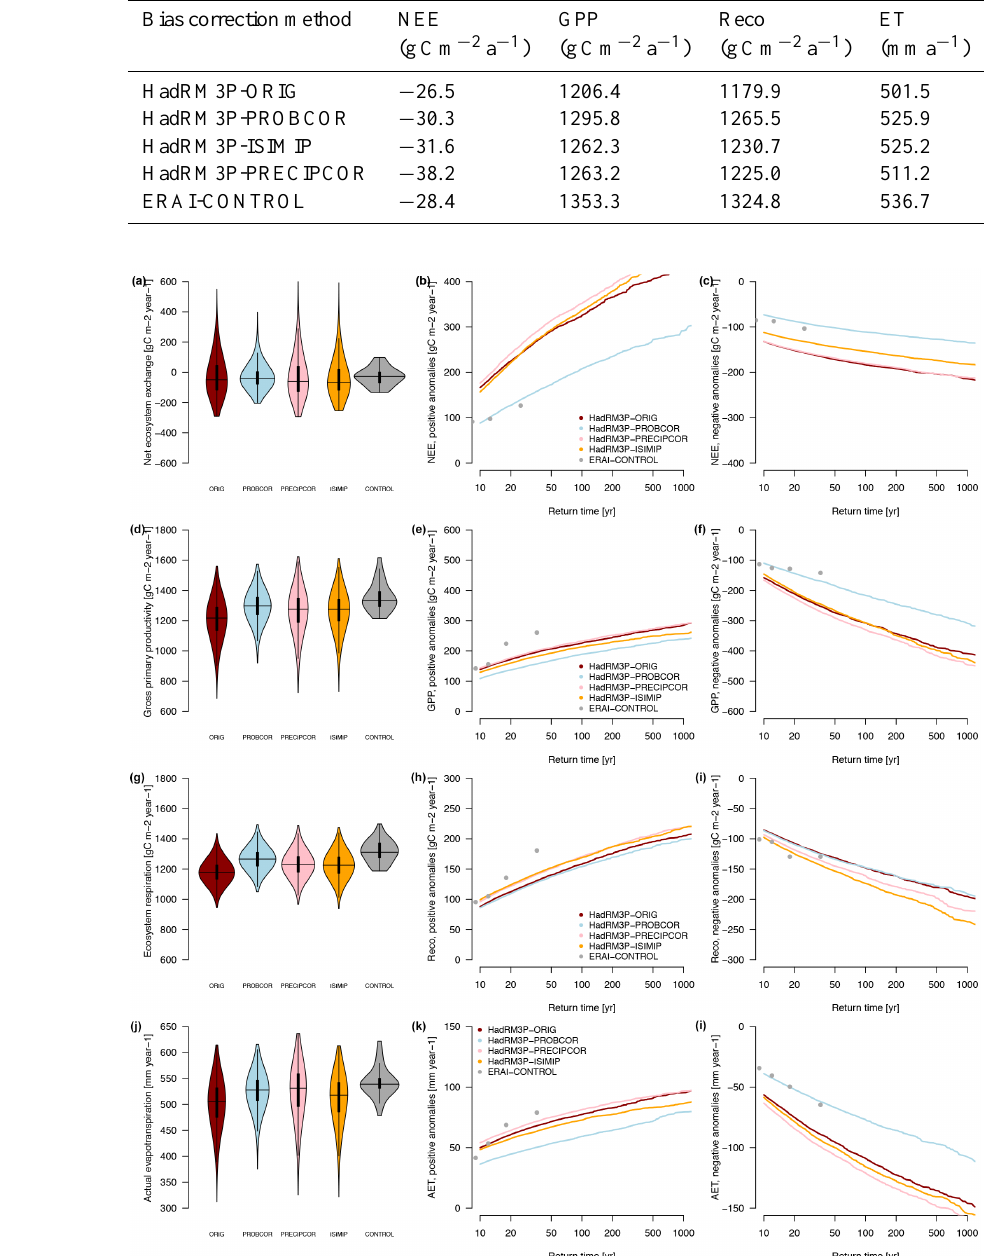
Figure 6. LPJmL simulated distributions of ecosystem–atmosphere carbon and water fluxes for Central European natural vegetation for each bias correction scheme. Each row shows the simulated distribution and the upper and lower tail of NEE (a, b, c) , GPP (d, e, f) , Reco (g, h, i) and AET (j, k, l) , respectively. (a, d, g, j) Both sides of each violin are constructed as rotated, equal-area kernel density estimates, and a standard box plot is drawn inside each